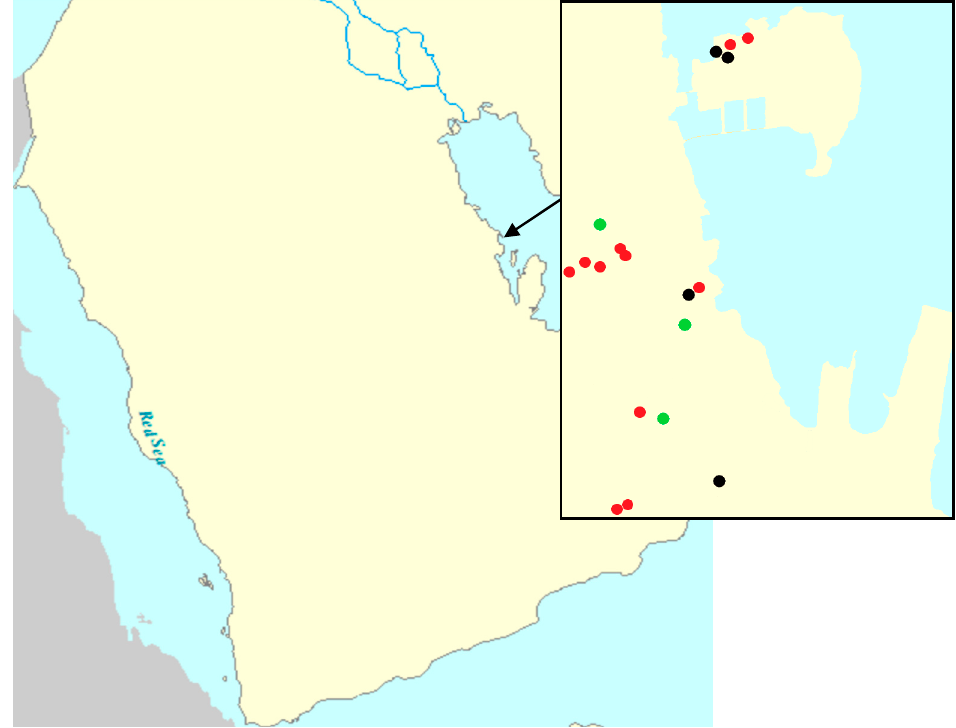
Figure 1. Map of Saudi Arabia showing sampling sites from the Eastern Province in different areas: agricultural (green circle), industrial (black circle), and residential (red circle) (Produced by the author).